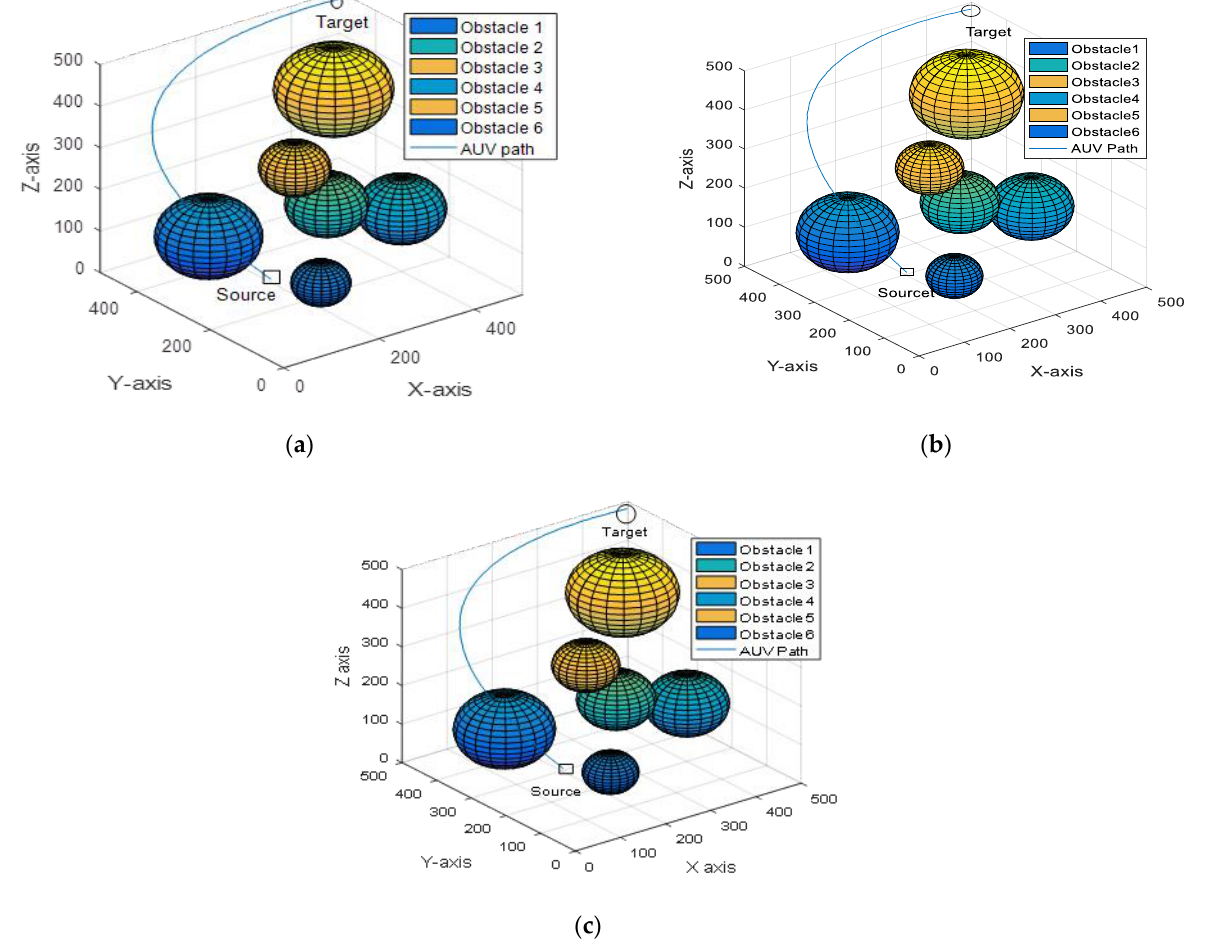
Figure 5. 3D view of the resultant path by applying: ( a ) GA; ( b ) GWO; ( c ) HGWO. Table 1. Analysis of the GA, GWO and HGWO performances for path planning of a single